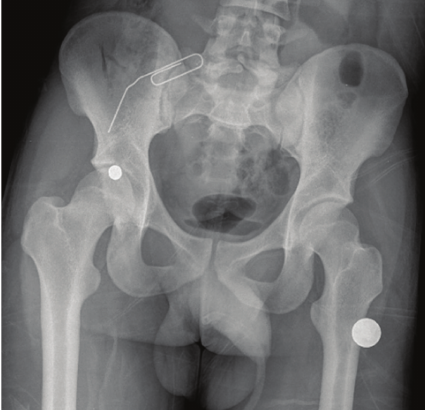
Figure 1: AP pelvis radiograph showing the bullet in the right femoral head. The tip of the paper clip shows the entry wound.